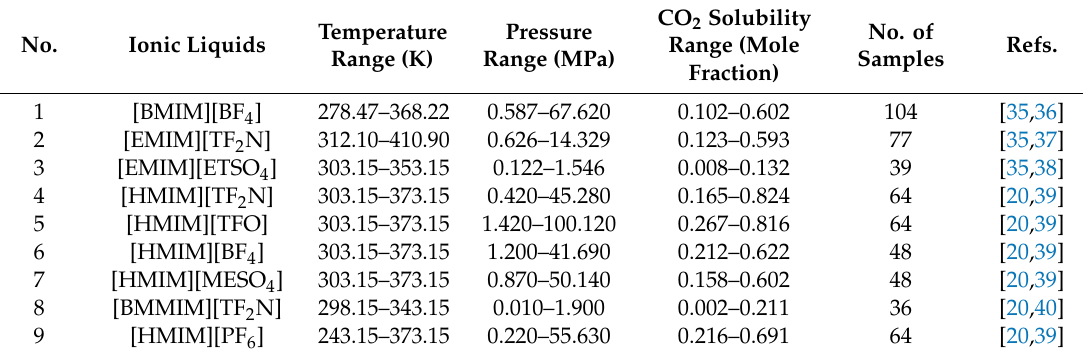
Table 2. Input and output parameters used to construct